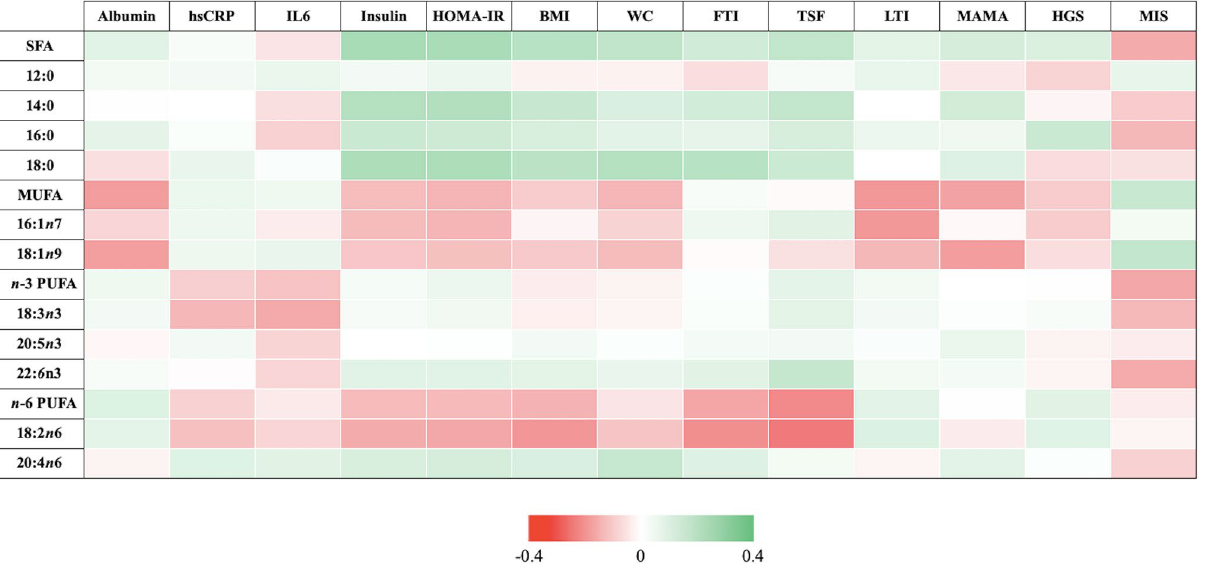
Figure 2. Correlation matrices between triglyceride fatty acids and biochemical markers, body composition, physical strength, and nutritional status. Correlations are represented by different colour cells: the red scale ( r = 0 to − 0.4) indicates negative associations while the green scale ( r = 0 to 0.4) indicates positive